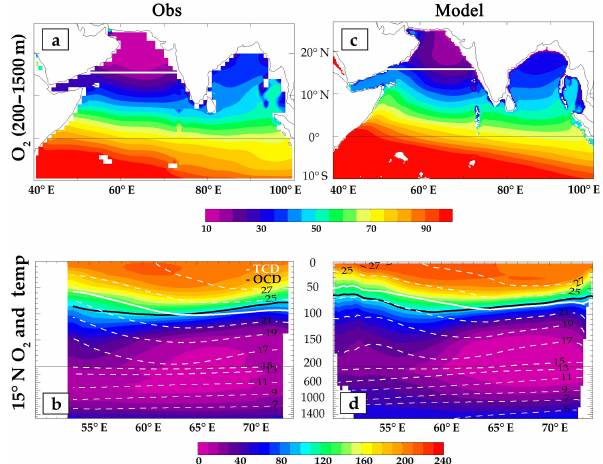
Figure 3. (a) Map of yearly climatological O 2 concentration (µmolL − 1 ) averaged between 200 and 1500m depths in the north- ern Indian Ocean from WOA13. (b) The vertical distribution of yearly climatological O 2 (µmolL − 1 ; shaded) and temperature ( ◦ C; dashed white contours with 2 ◦ C interval) across the east–west sec- tion at 15 ◦ N (indicated by white line in panels a and c ) in the Ara- bian Sea from WOA13 data. (c, d) Same as (a, b) but for the model. Depths of 23 ◦ C isotherm (white line) and of 100µmolL − 1 isoline (black line) are marked in panels (b) and (d)